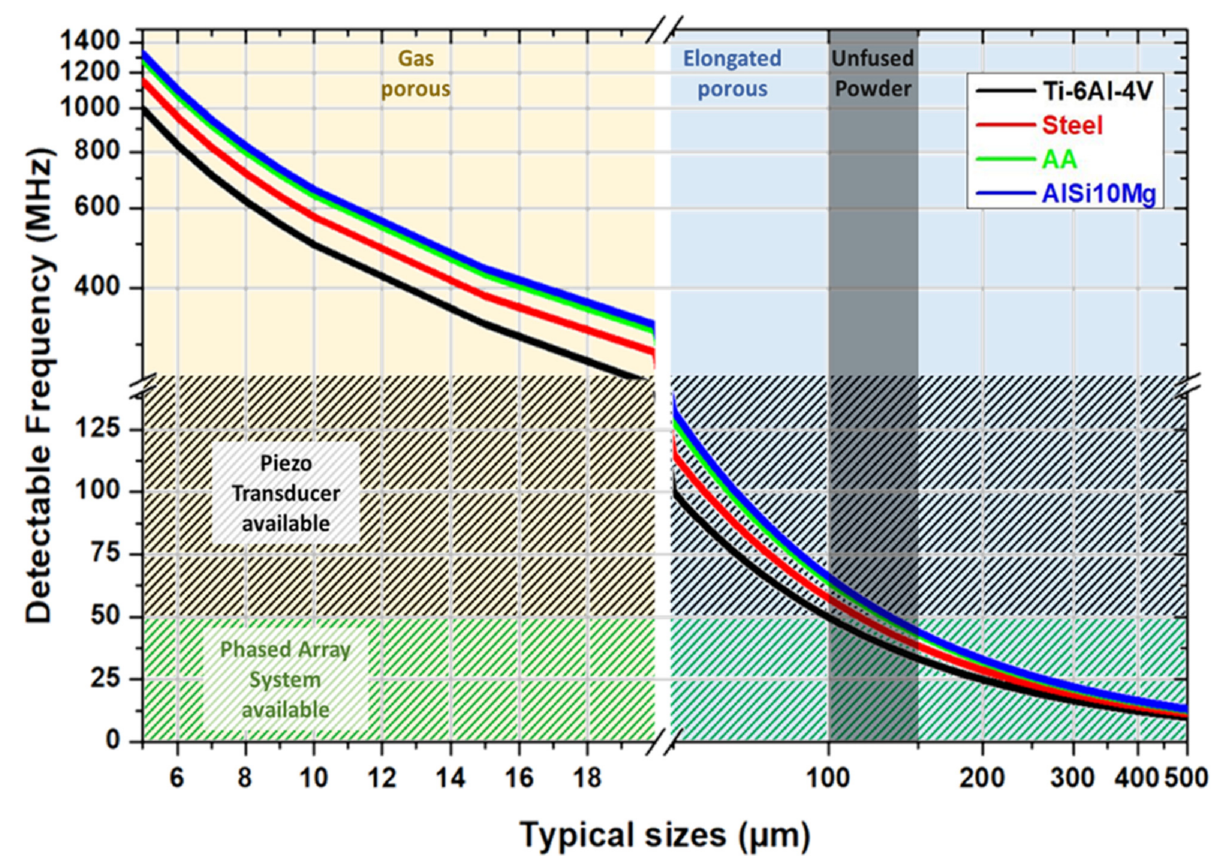
Figure 15. Theoretical detectable ultrasound frequency of gas porous (yellow shadowed), elongated porous (blue shadowed), and unfused powder (grey shadowed) in SLM-printed Ti6Al4V (black line), steel (red line), aluminum alloy (green line), and AlSi10Mg (bue line). 250 MHz and lower frequency range are available in the commercial piezo-element transducer market. 50 MHz and lower frequency range are available to obtain a commercial phased-array